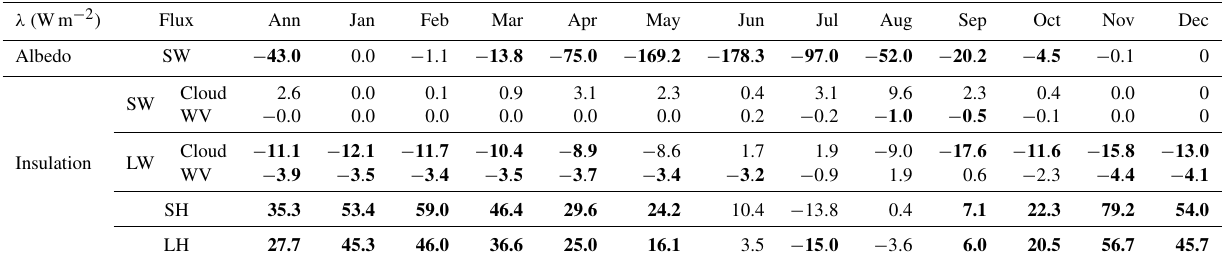
Table 4. The response coefficients (Wm − 2 ) of radiation and turbulent heat fluxes to the albedo and insulation effects of sea ice. Those significant at a 99% confidence level are given in bold. SW, LW, SH and LH refer to net shortwave flux, net longwave flux, sensible heat flux and latent heat flux,